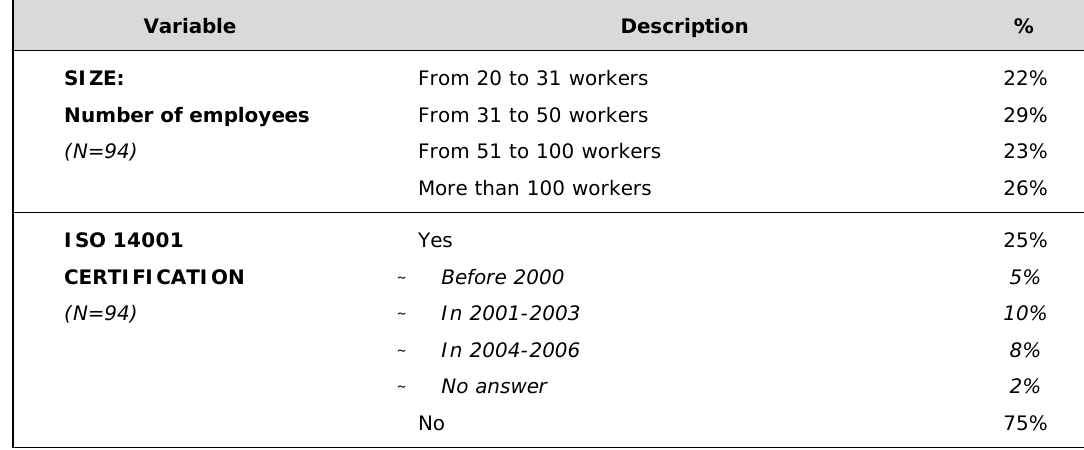
Table 1. “Description of the sample